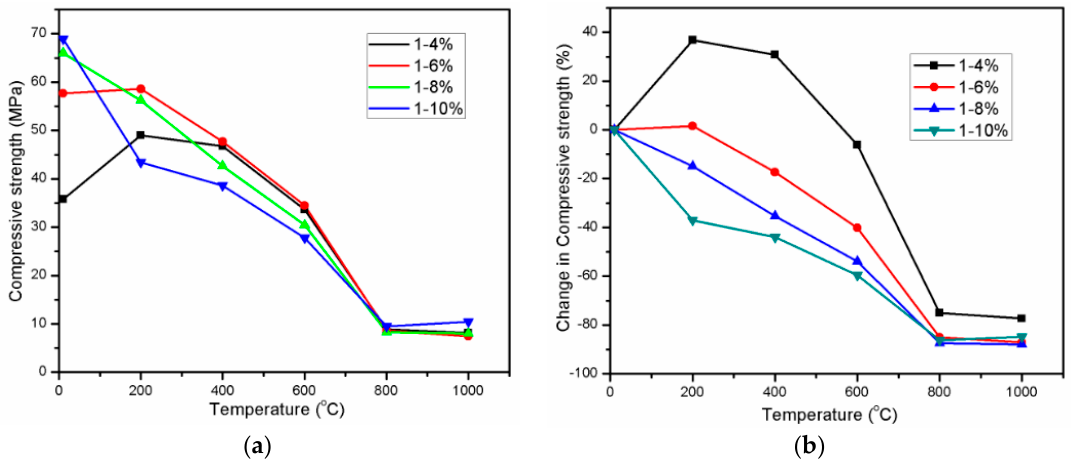
Figure 3. Residual compressive strength ( a ) and change in compressive strength ( b ) of alkali activated slag (AAS) mortar.